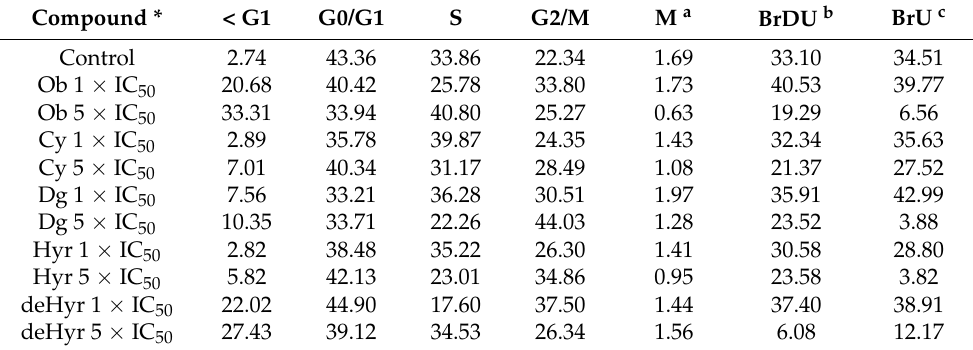
Table 3. Effect of cytotoxic compounds on cell cycle, apoptosis, and DNA/RNA synthesis in CCRF- CEM lymphoblasts (% of positive cells). Flow cytometry analysis was used to quantify cell cycle distribution and the percentage of apoptotic cells. The sum of the percentages for G0/G1, S, and G2/M is equal to 100%. a Phospho-Histone3 (Ser10); b BrDU, 5-bromo-2-deoxyuridine; c BrU, 5-bromouridine.